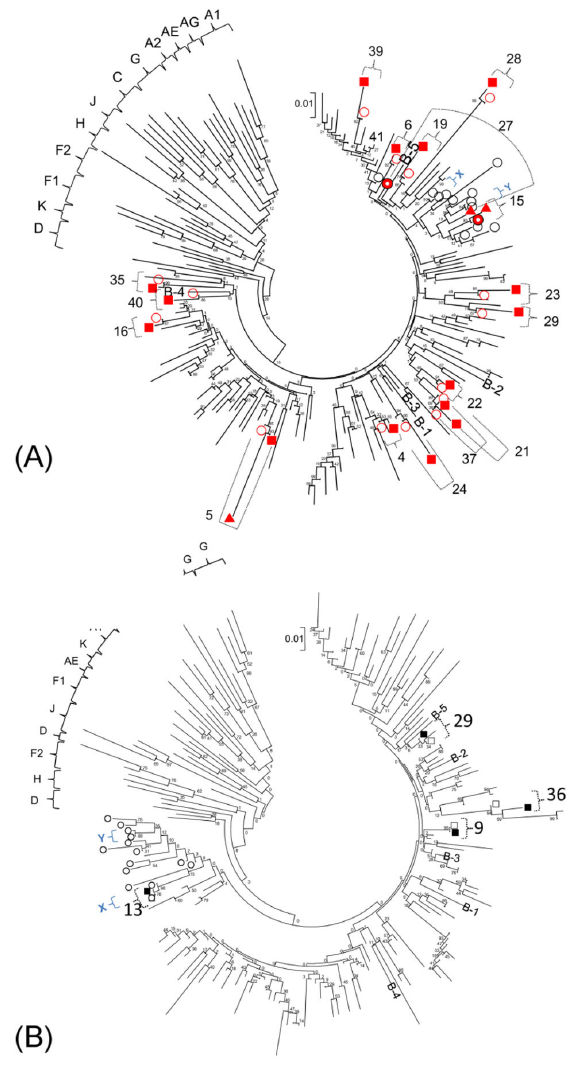
Figure 4. Phylogenetic tree of samples with or without minority variants of M46I/L or L90M drug resistance. A neighbor-joining phylogenetic tree of all protease sequences using the Kimura 2-parameter model was generated in MEGA5. Numbers shown are IDs of patients with detectable minority drug resistance. Open circles (black color) are virus with M46I detected by bulk sequencing. A. Solid squares (red color) indicate sequences of M46I-specific amplicons and solid triangle (red color) indicate sequences of M46L amplicons; open circles (red color) indicate bulk sequences for persons with minority M46I/L mutations; X and Y are pairs of closely related transmitted M46I sequences. B. Solid squares indicate L90M-specific amplicon sequences; open squares indicate bulk sequences for persons with minority L90M mutations. Open circles (black color) are virus with M46I detected by bulk sequencing. Abbreviations of subtype B references: B-1; B.NL. 00.671 00T36.AY423387, B-2; B.US.98.1058 11.AY331295, B-3; B.FR.83.HXB2 LAI IIIB BRU.K03455, B-4; B.TH. 90.BK132.AY173951, B-5; B.US.98.15384